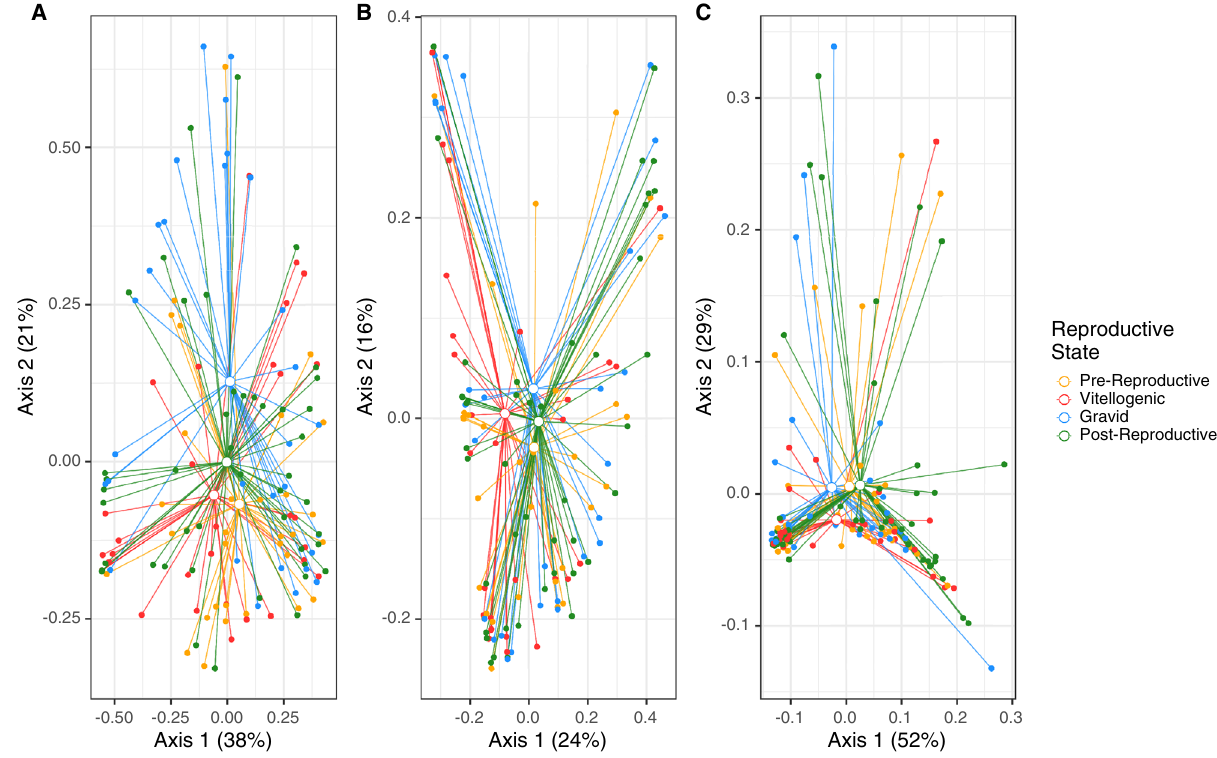
Figure 5. PCoA for cloacal microbiomes of female S. virgatus across four reproductive states, based on ( A ) Bray–Curtis, ( B ) unweighted UniFrac, and ( C ) weighted UniFrac distances. Open dots represent the centroids of each group, and solid dots represent each sample. Colors represent each reproductive